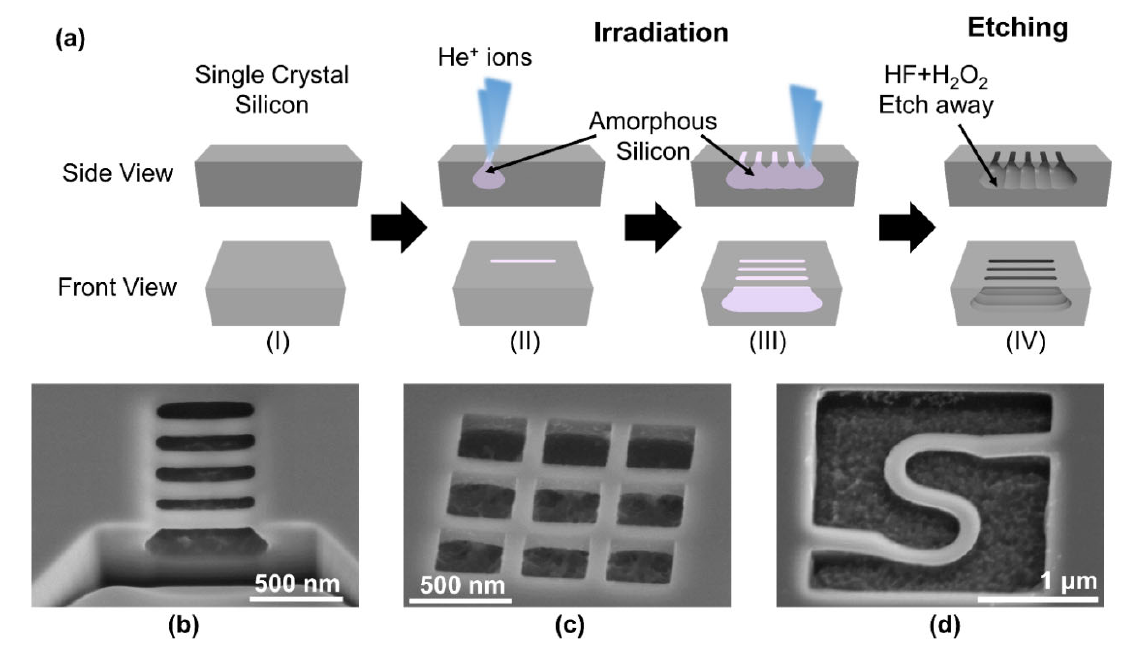
Figure 8. ( a ) Fabrication process of suspended nanobeams using HIBEE including starting from a single crystal silicon substrate (step I), helium ion irradiation (step II & III), and wet etching (step IV). SEM images of ( b ) an array of suspended straight nanobeams, ( c ) a suspended Si nano ‐ mesh, and ( d ) a suspended serpentine Si nanobeam. ( d ) a suspended serpentine Si